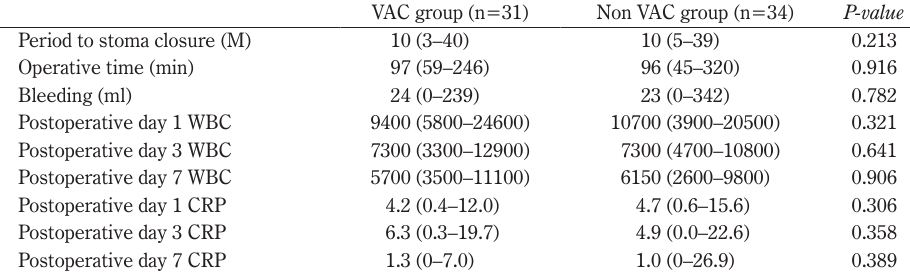
Table 2 Demographic and operative outcome data of the VAC group and non VAC group